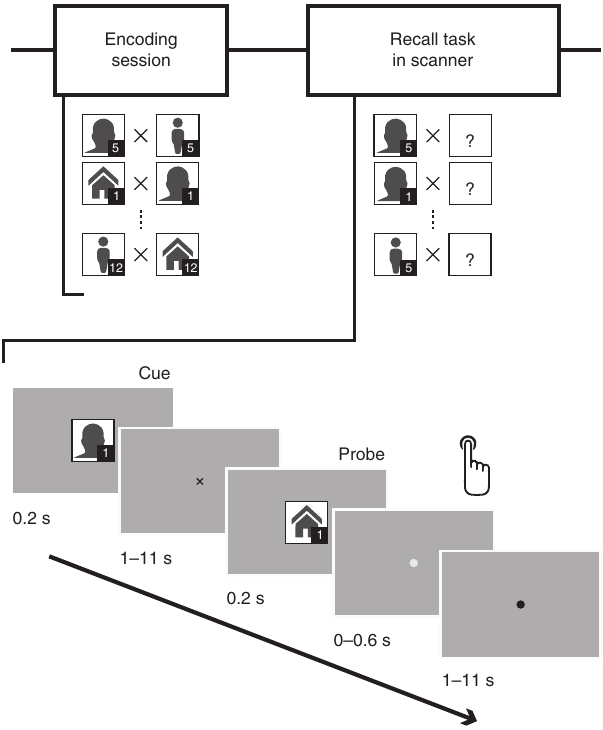
Figure 1 | Experimental procedure and trial structure. Top: participants learned the associations between grayscale pictures depicting either a face plus body, scene plus face or body plus scene, during an initial encoding session. Subsequently, participants retrieved these associations in the scanner. Note that in the actual experiment, category icons and pair numbers (used here for illustration purposes) were replaced by photographic stimuli, as described in the Methods. Bottom: each retrieval trial comprised a cue, a retrieval phase of variable length and the presentation of a match or non-match probe stimulus (bottom). Participants indicated whether the probe matched the paired-associate by button press. Trials were separated by a variable inter-trial